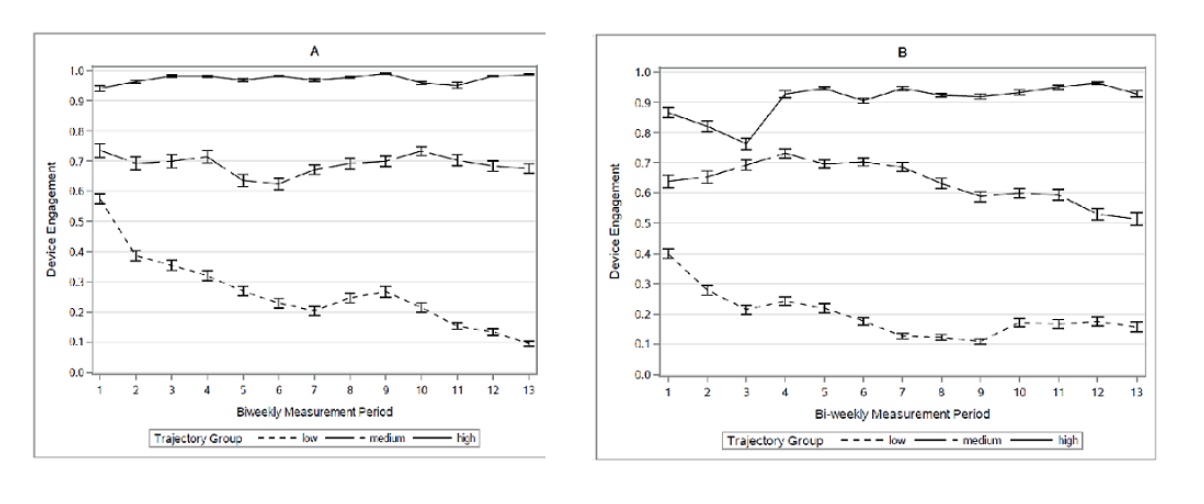
Figure 2. Empirical summary plot for biweekly engagement trajectories with the (A) glucometer and (B) wireless weight scale by different engagement